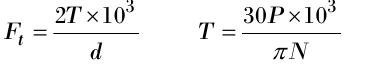
Fig. 1b: Fully reversed bending